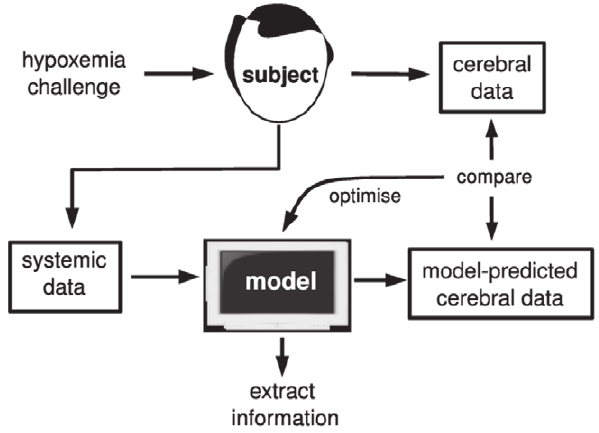
Figure 3. Schematic of the model optimisation methodology. Healthy subjects undergo a hypoxemic challenge, during which systemic and cerebral data is gathered noninvasively. The systemic data is fed into the physiological model, which then predicts expected values of the cerebral signals. The difference between measured and predicted values of these signals is used to construct an objective function, and minimisation of this function is used to reparametrise the